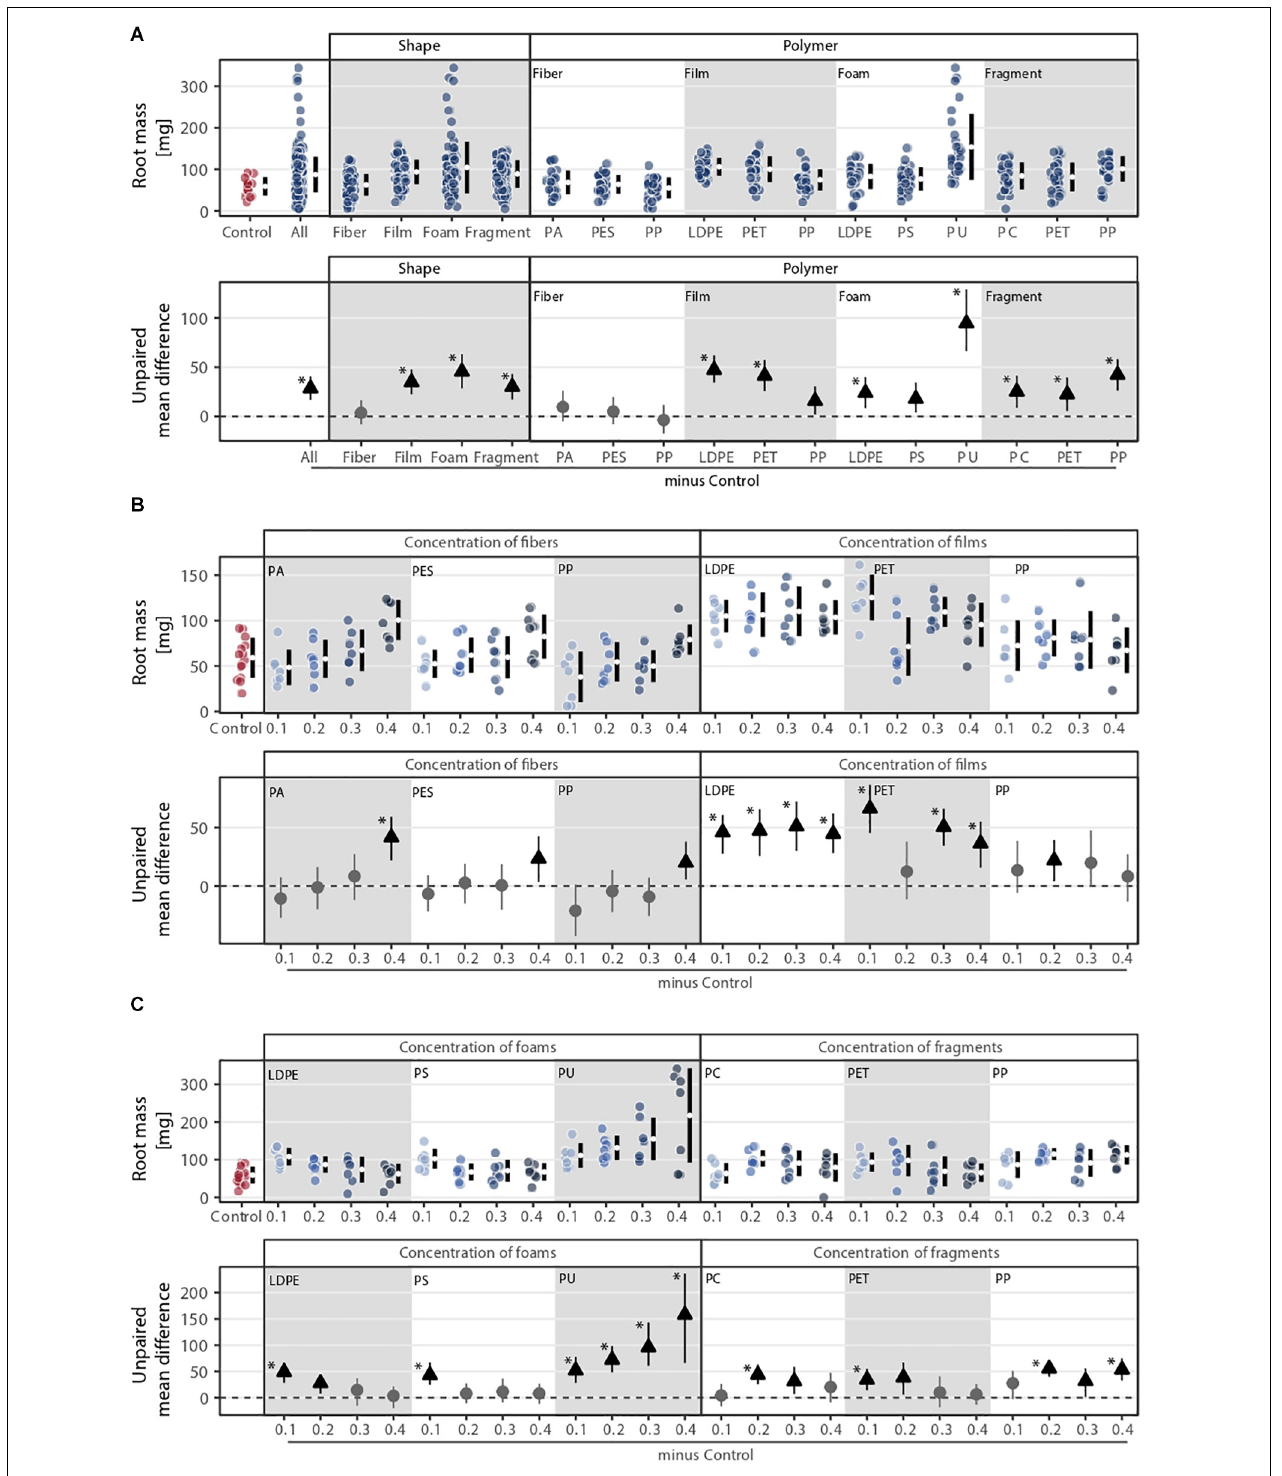
FIGURE 3 | Root mass response to (A) microplastic shape and polymer type at (B–C) different concentrations (0.1, 0.2, 0.3, and 0.4%). That is, (B) concentration of fibers and films and (C) concentration of foams and fragments. Effect sizes and their variance are displayed as means and 95% confidence intervals. Effects are color-coded: gray circles indicate neutral effect sizes and black arrows with an arrow head pointing upward indicate positive effects; no negative effects were detected. Horizontal dotted line indicates the mean difference value between each microplastic and the control. Polymers: PA (polyamide), PES (polyester), PP (polypropylene), LDPE (low density polyethylene), PET (polyethylene terephthalate), PS (polystyrene), PU (polyurethane), and PC (polycarbonate). Significance was established at 0.05 ( Supplementary Tables S1–S3 ); n = 7 for microplastics, n = 14 for control samples.